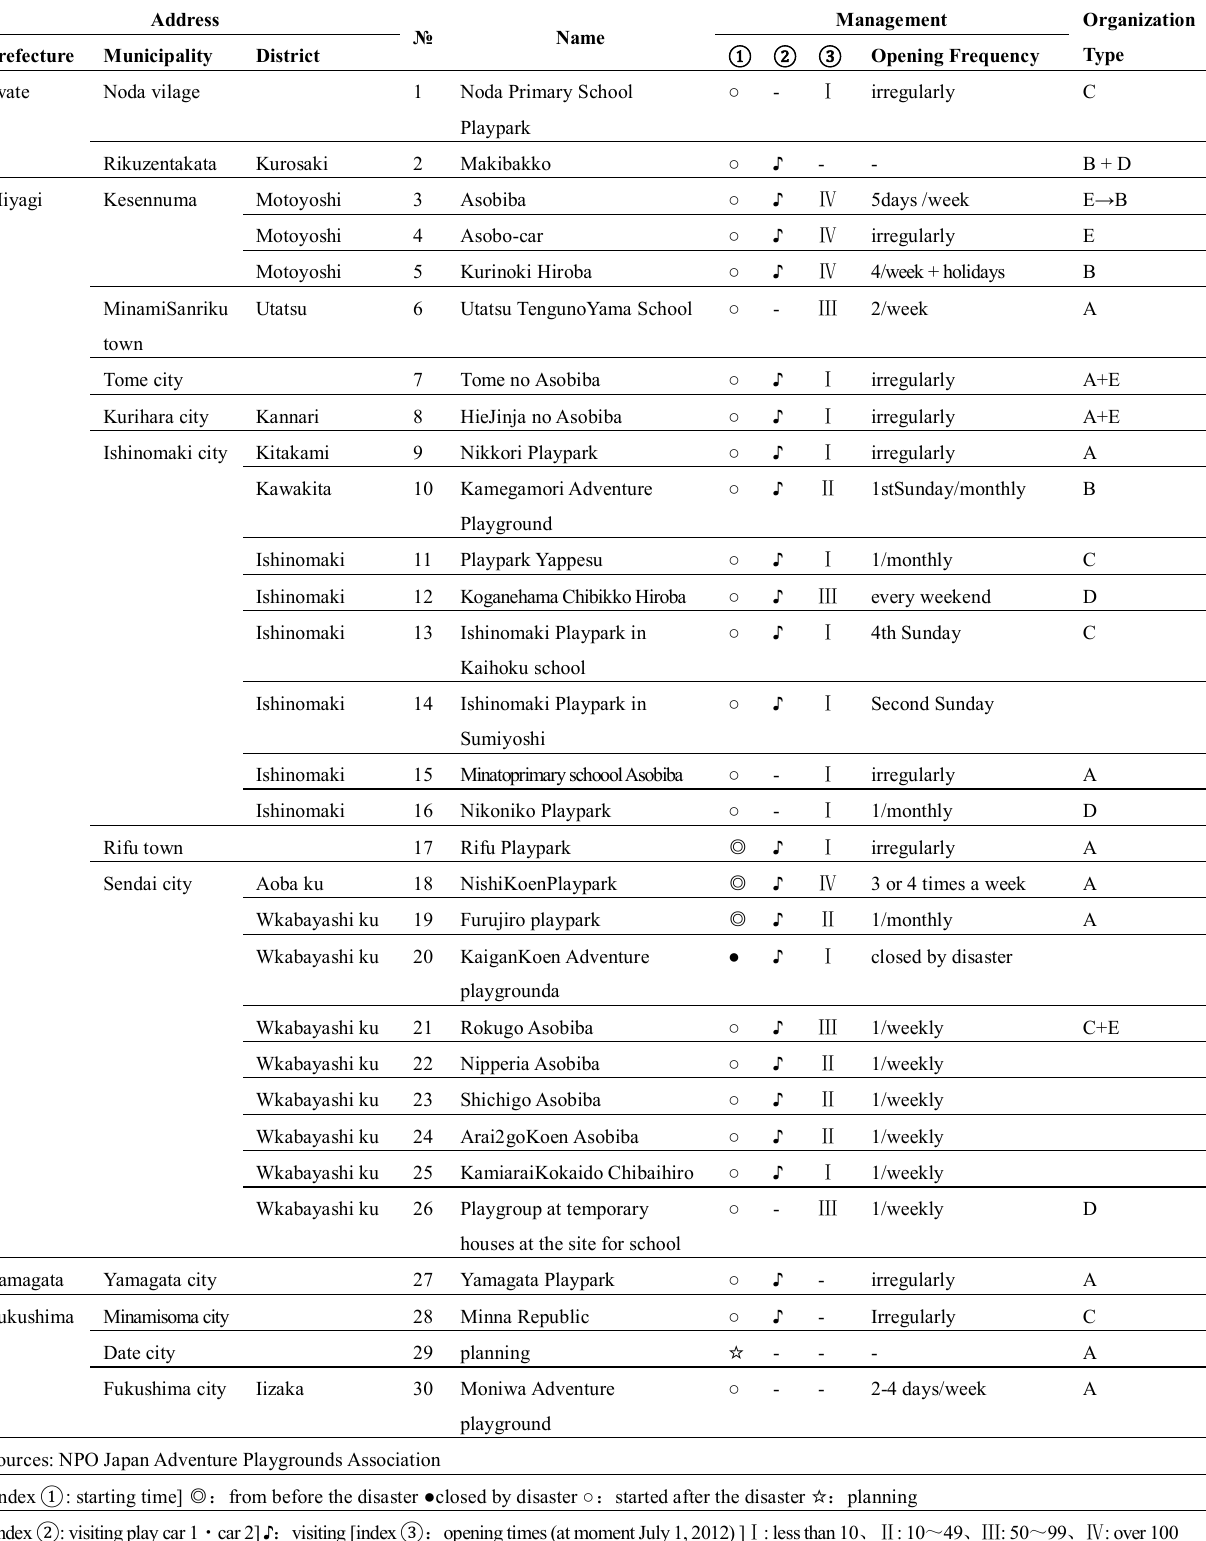
Table 2. Adventure playgrounds in the Tohoku Area. (original data was given from Mr. Tsutom Sunaga to use with his permission. This shows the situation on July, 2012 which movement is